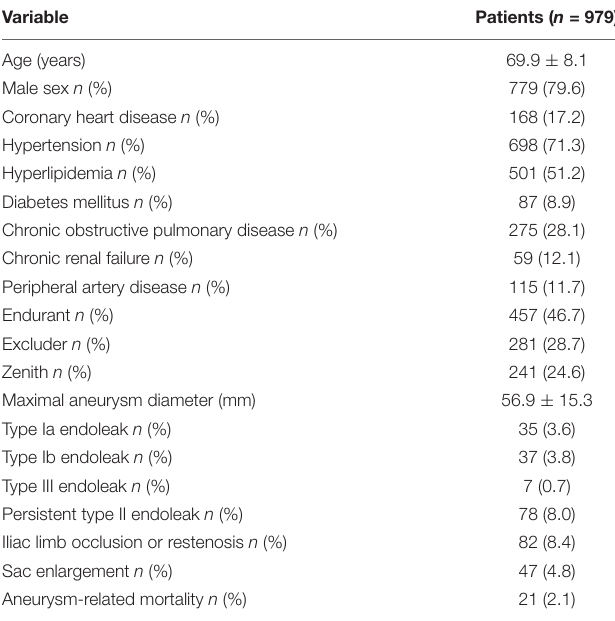
TABLE 1 | Clinical characteristics and outcomes of patients with